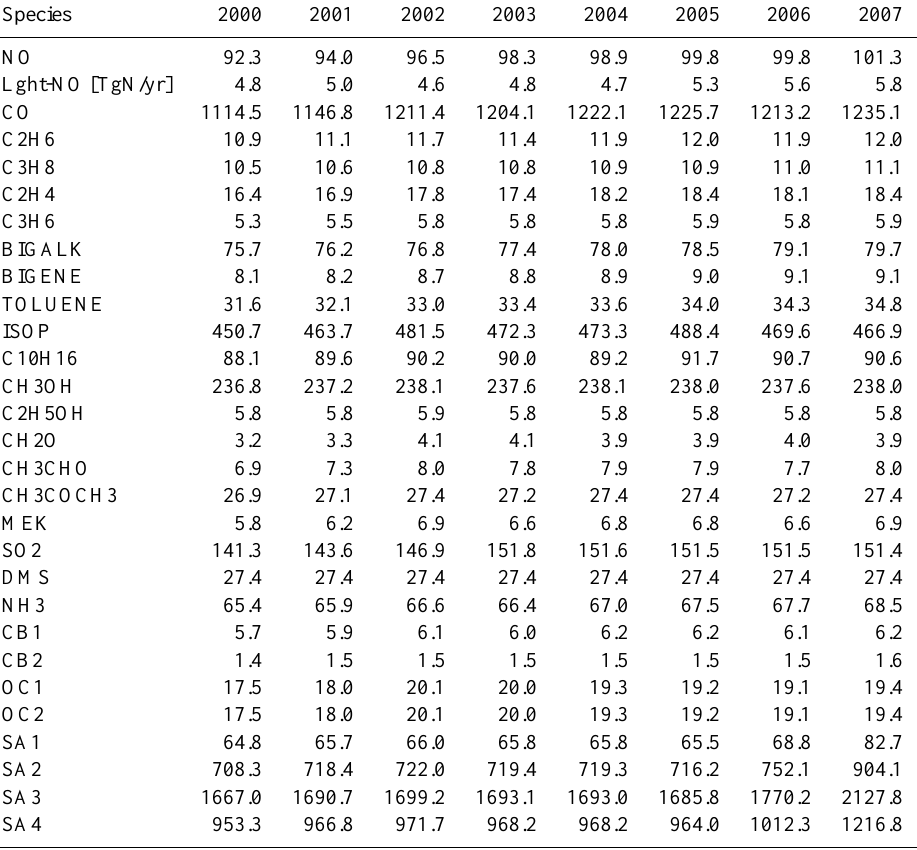
Table 10. Emissions totals for 2000–2007 in Tg(species)/year. Species NO